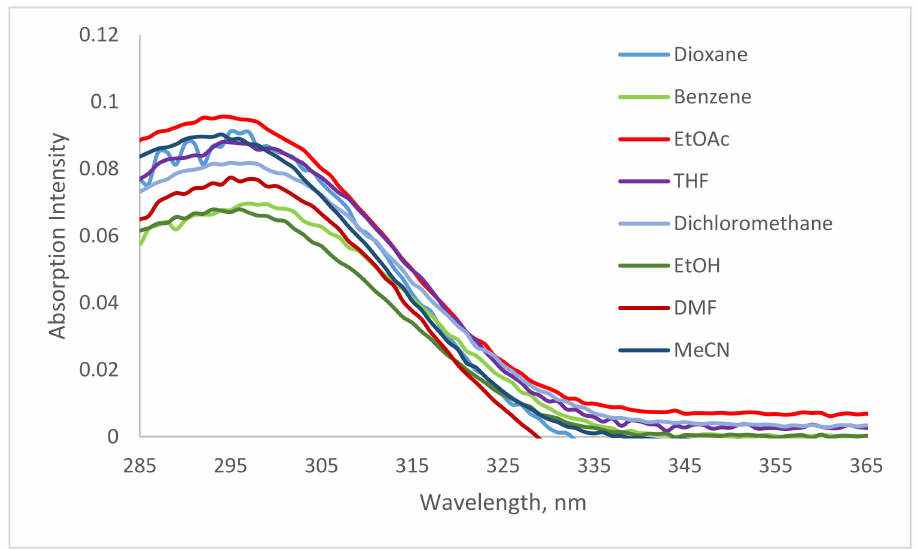
Figure 8. Absorption spectra of 4l in di ff erent solvents at room temperature.